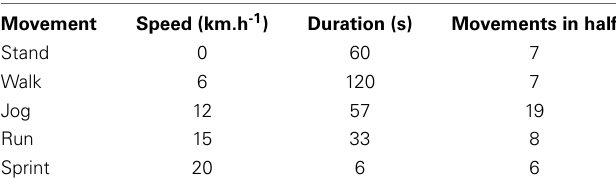
Table 2 | Speed and durations of the 5 different movements during the 90min intermittent sprint exercise